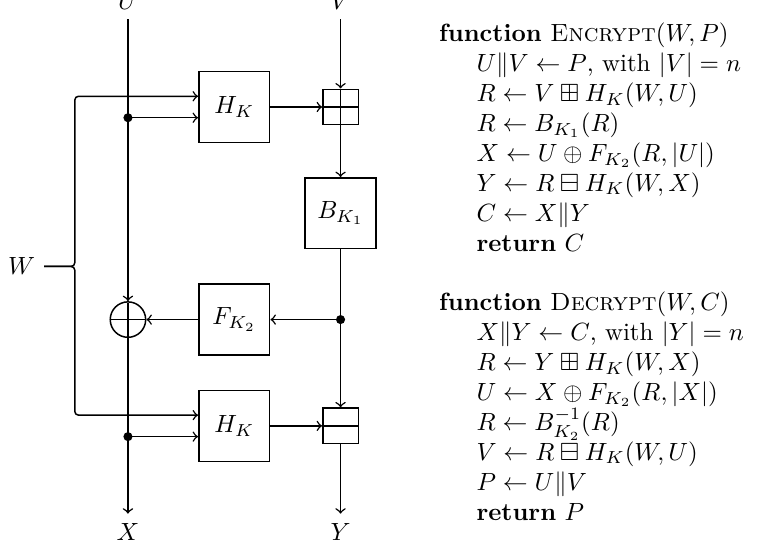
Figure 4: Adiantum mode (originally called HBSH in